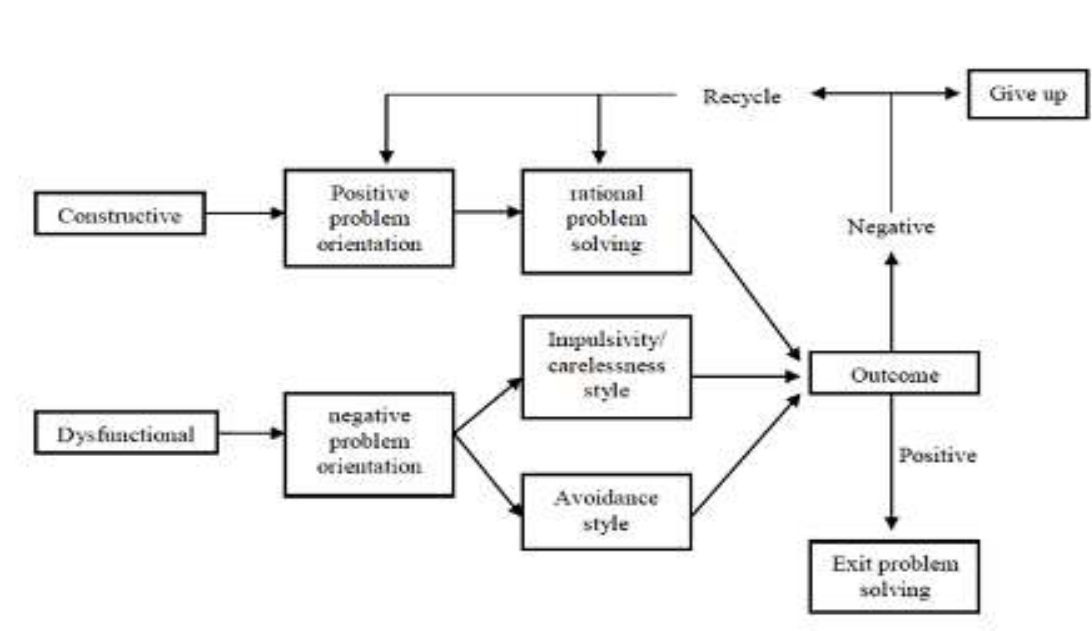
Fig. 1 Schematic representation of the social problem-solving process based on the five-dimensional